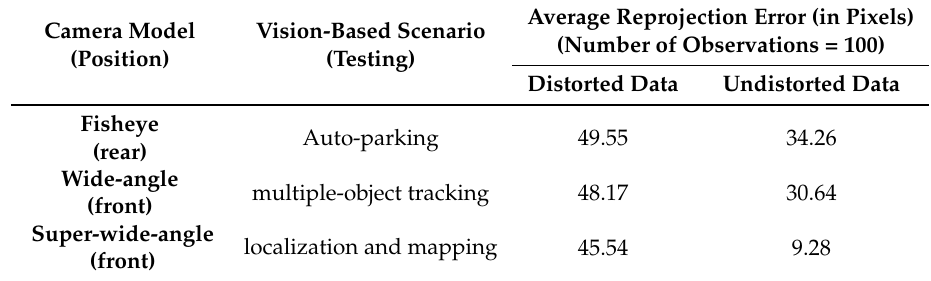
Table 7. Average reprojection error: Real-time testing in the context of vision-based scenarios on Distortion and Undistortion data from various sensor models.